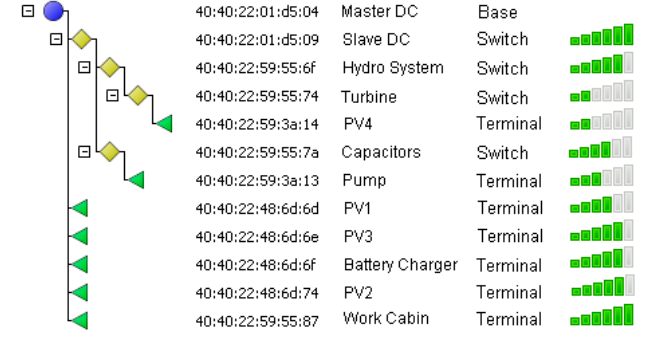
Figure 12. PRIME subnetwork topology obtained for the transformation centre under analysis in the microgrid at CEDER-CIEMAT facilities.